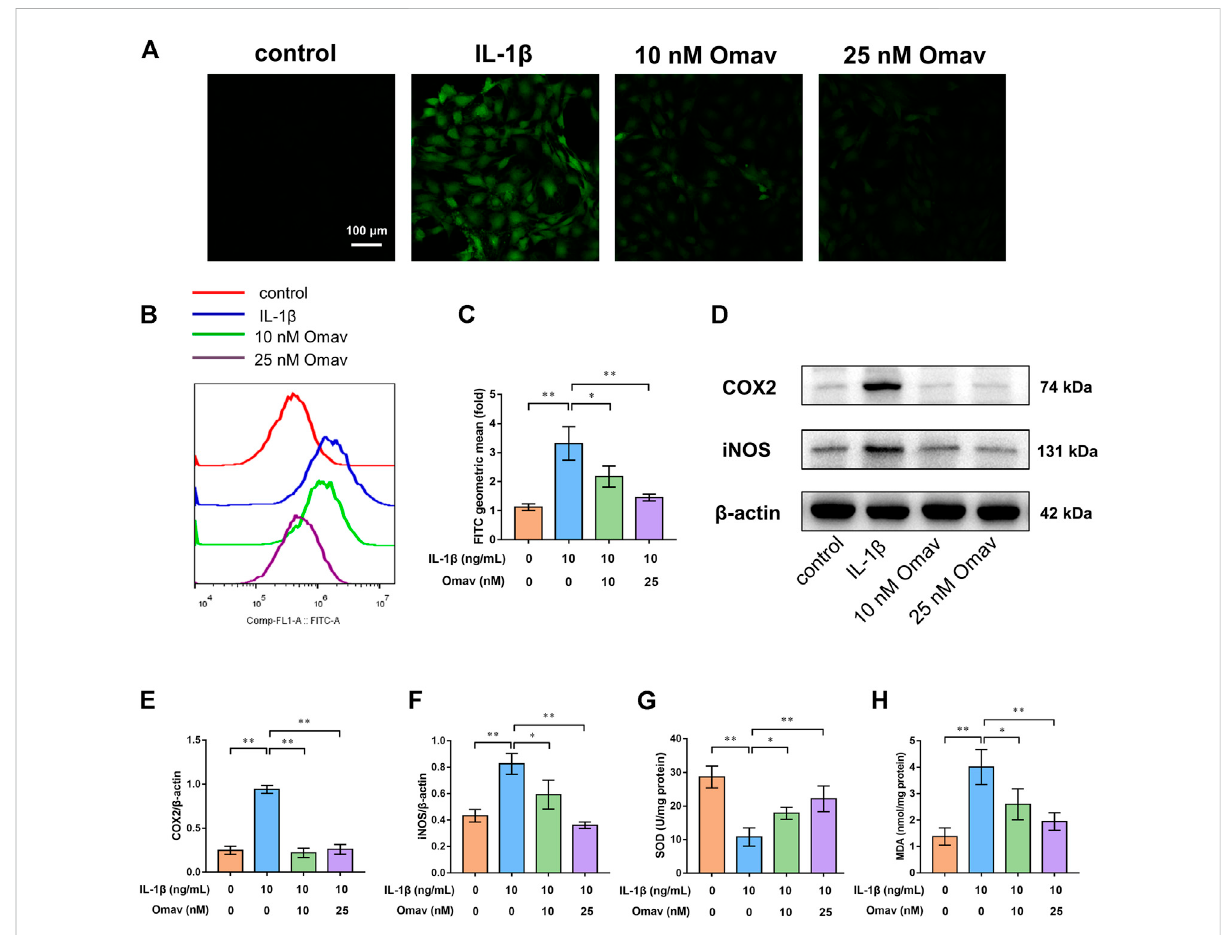
Omaveloxolone exerted antioxidative and anti-in fl ammatory effects on chondrocytes exposed to IL-1 β . (A) Representative fl uorescence confocal microscopic images of chondrocytes stained with DCFH-DA (scale bar, 100 μ m). (B and C) Chondrocytes stained with DCFH-DA were assessed by fl ow cytometry to quantify the ROS level. (D) Representative Western blots. Quantitative analysis of COX2 (E) and iNOS (F) was performed. (G) The SOD levels in chondrocytes among the four groups. (H) MDA levels in chondrocytes among the four groups. * p < 0.05 and ** p <